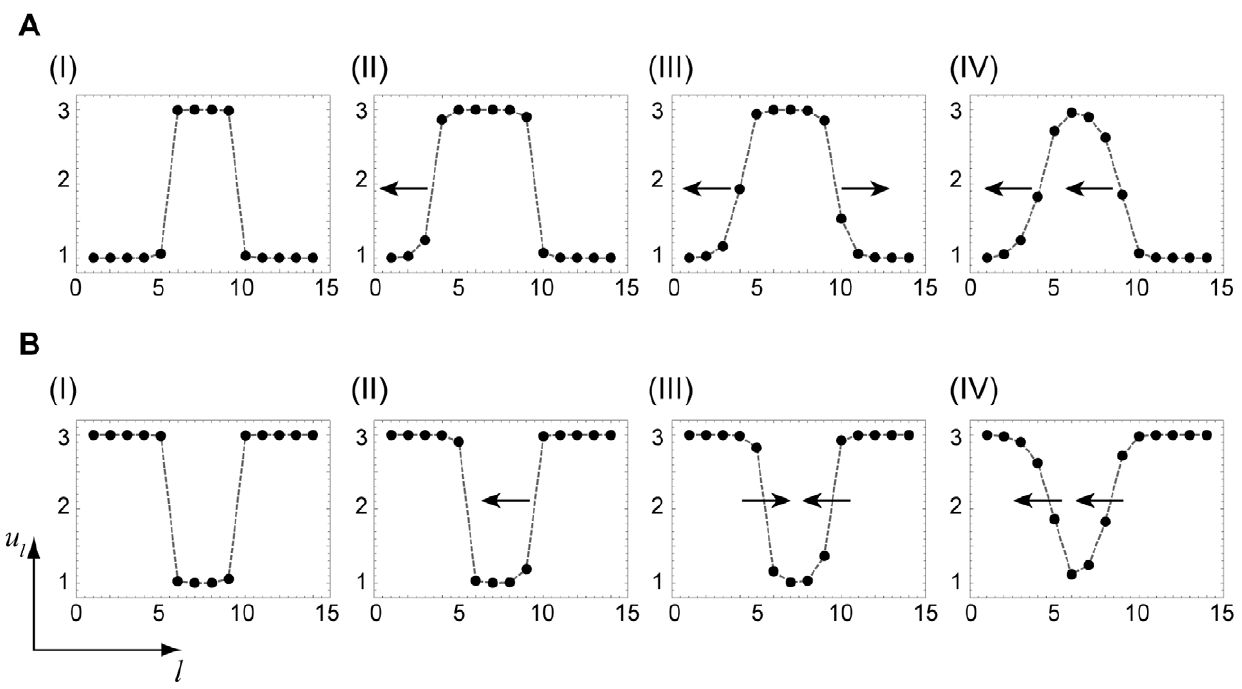
Figure 11. Nonlinear evolution of local perturbations. The evolution of different local perturbations (A,B) is shown in various regions of the bifurcation diagram. The arrows show the propagation direction. The parameter values are (I) k ~ 3, D ~ 0 : 01 , (II) k ~ 6, D ~ 0 : 03 , (III) k ~ 3, D ~ 0 : 1 and (IV) k ~ 12, D ~ 0 : 1 . The other parameters are r 1 ~ 1, r 2 ~ 1 : 4 and r 3 ~ 3 .